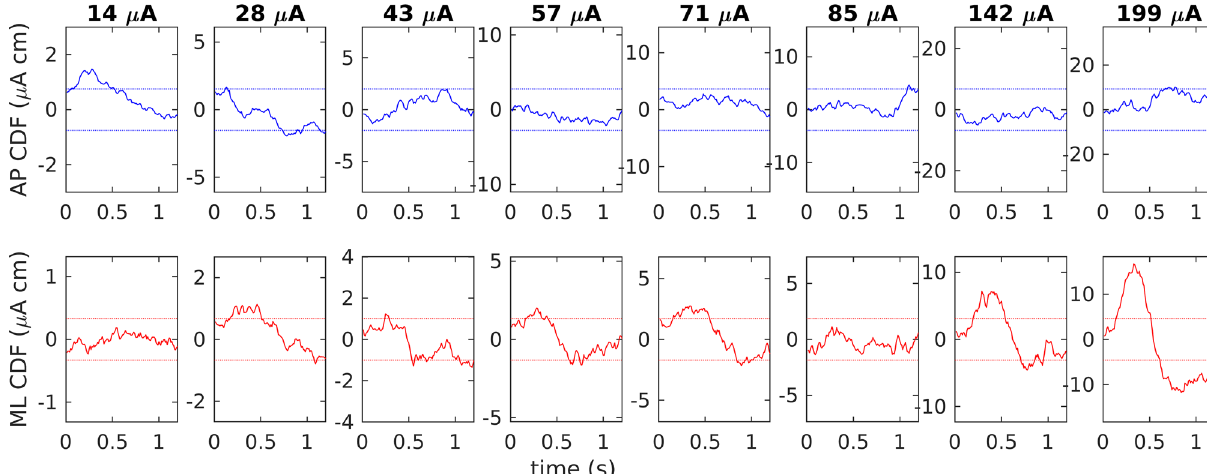
Figure 2. Cumulant density functions between COP and nGVS sequences for different stimulus amplitudes during quiet stance for anterior–posterior (blue, top row) and medio-lateral (red, bottom row) directions. Plots show the analysis results comprising all subjects. Dashed lines show 95% confidence bounds; plots are scaled with respect to the confidence bounds.